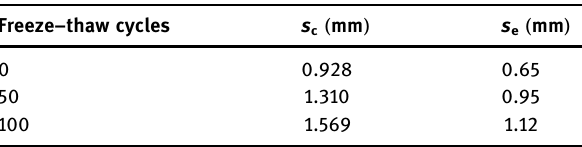
Table 4: The comparison of calculation results ( s c ) and experiment results ( s e )